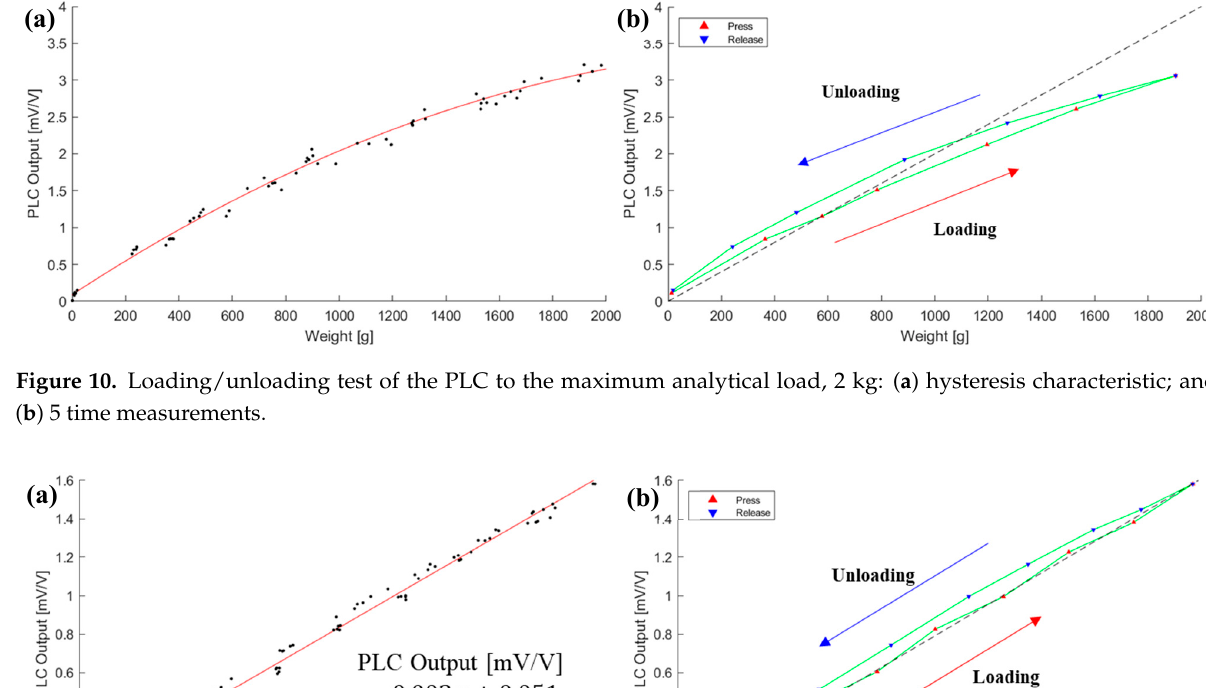
Figure 9. Temperature dependence of the PLC.